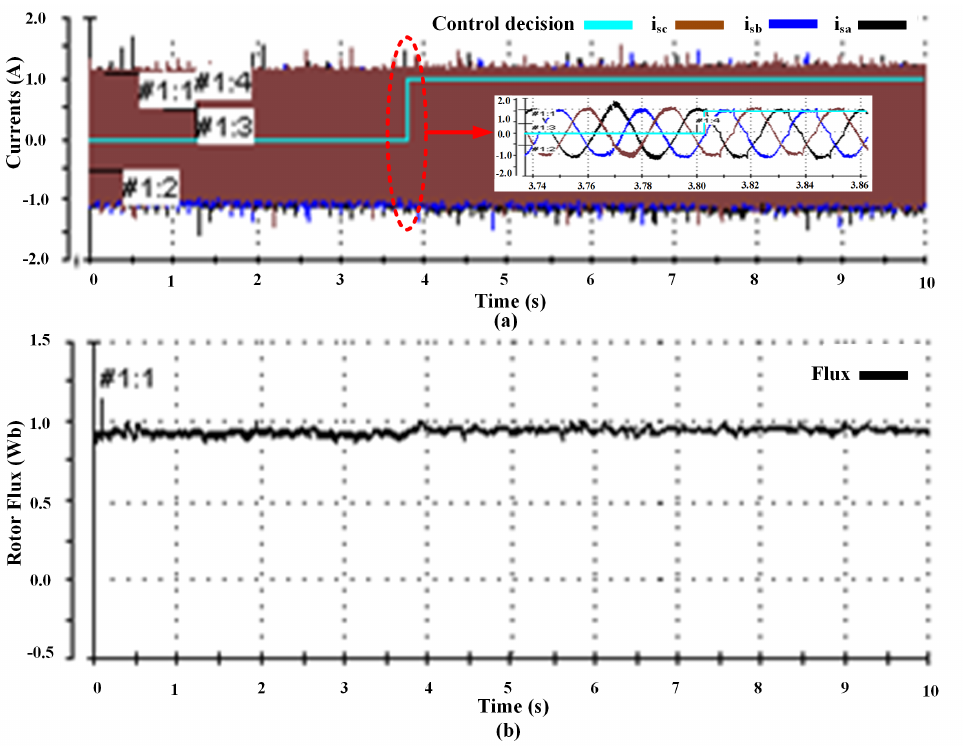
Figure 30. Experimental results of the two strategies: ( a ): stator currents; ( b ): rotor flux response.